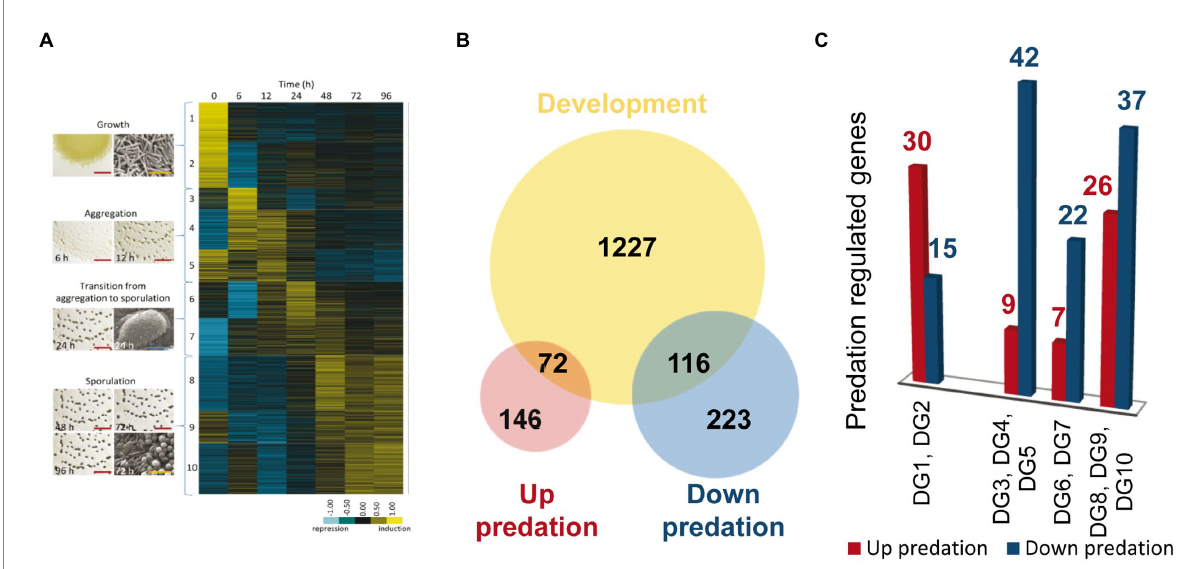
FIGURE 6 Differentially expressed genes (DEGs) during predation clustered in developmental groups (DGs) of M. xanthus . (A) DGs described by Muñoz- Dorado et al. (2019). (B) Venn diagram of up and down-DEGs during predation, and DEGs during development (not shown to scale). (C) Number of DEGs during predation included in each DG. As indicated in the text, DG1 and DG2 are downregulated genes during development, while DG3- 10 are genes upregulated during